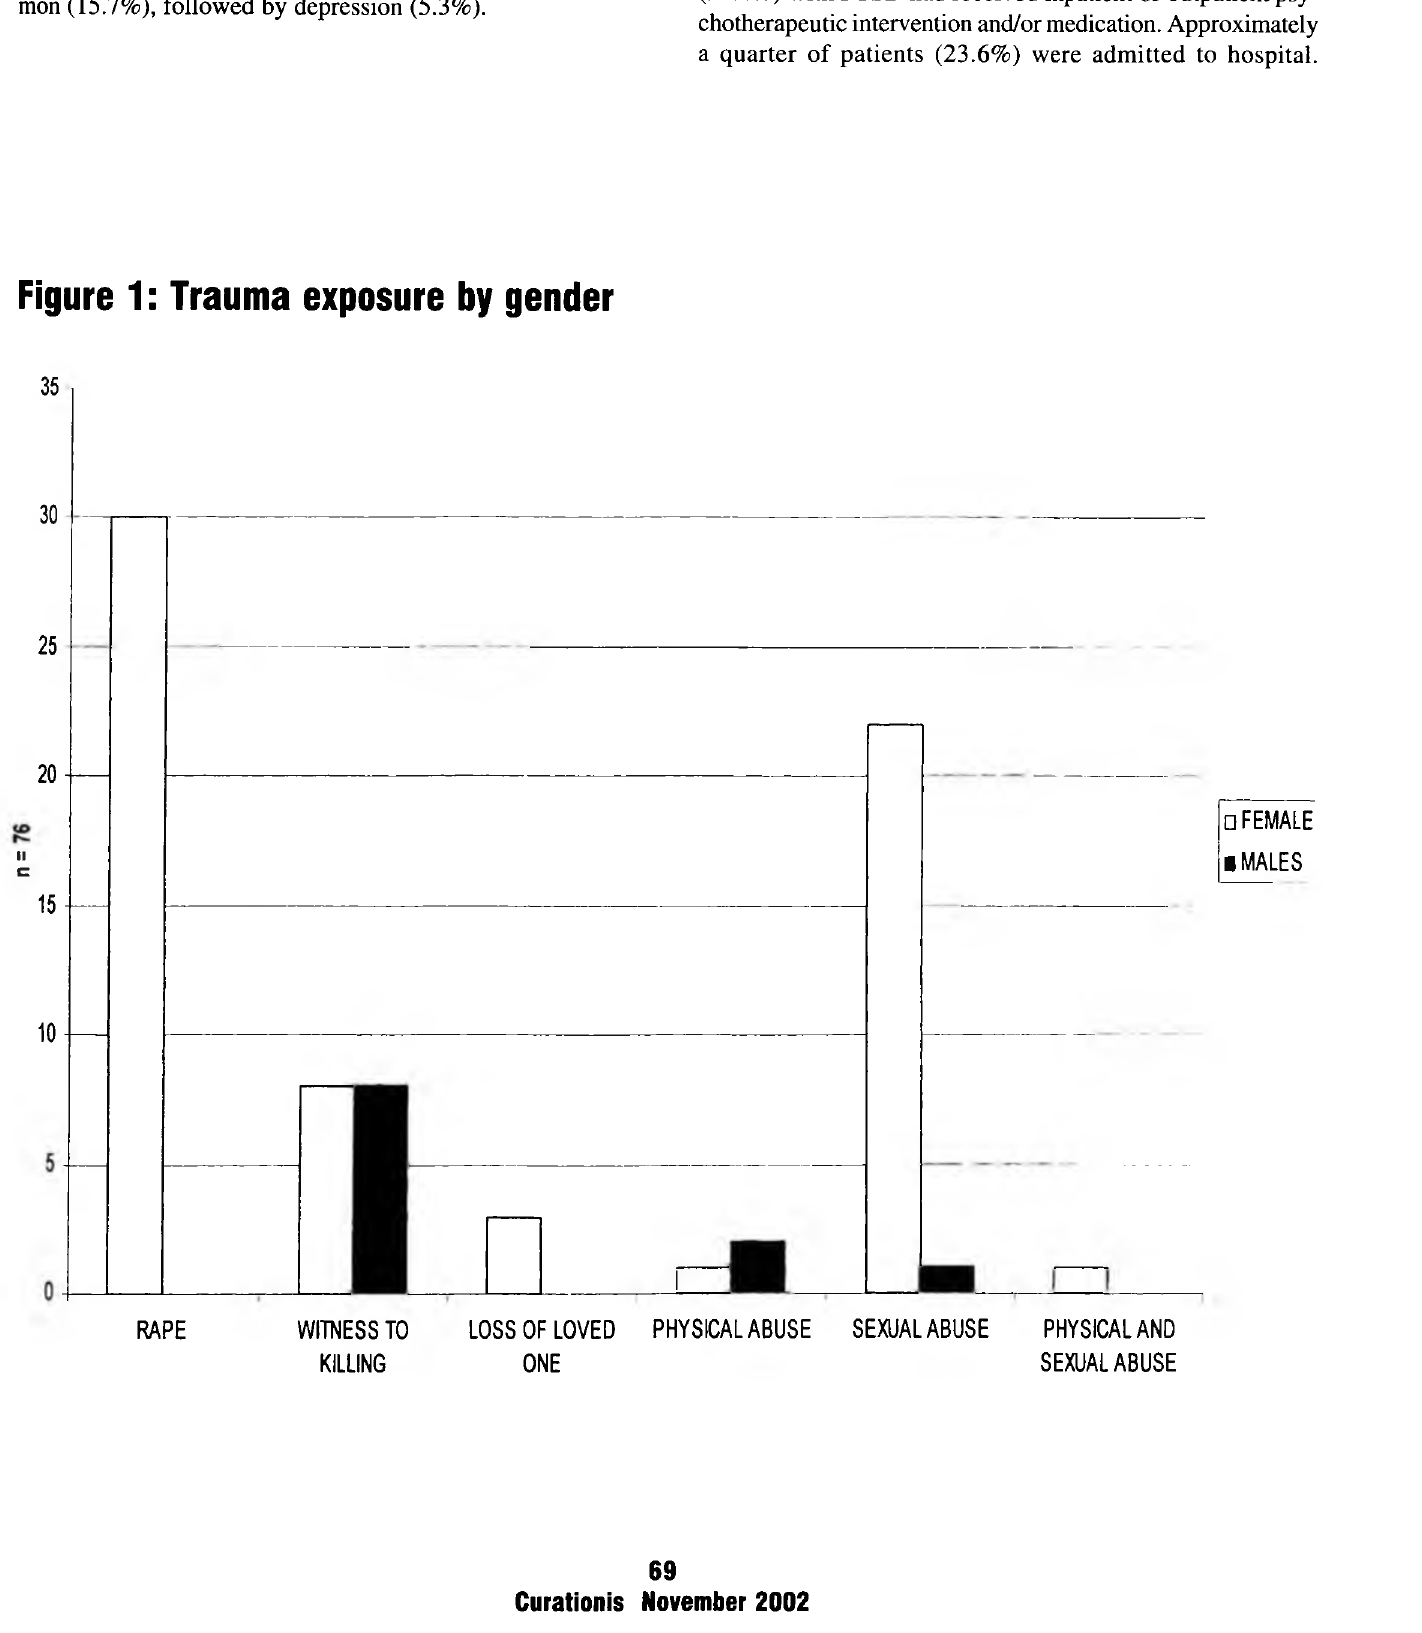
Figure 1 : Trauma exposure by